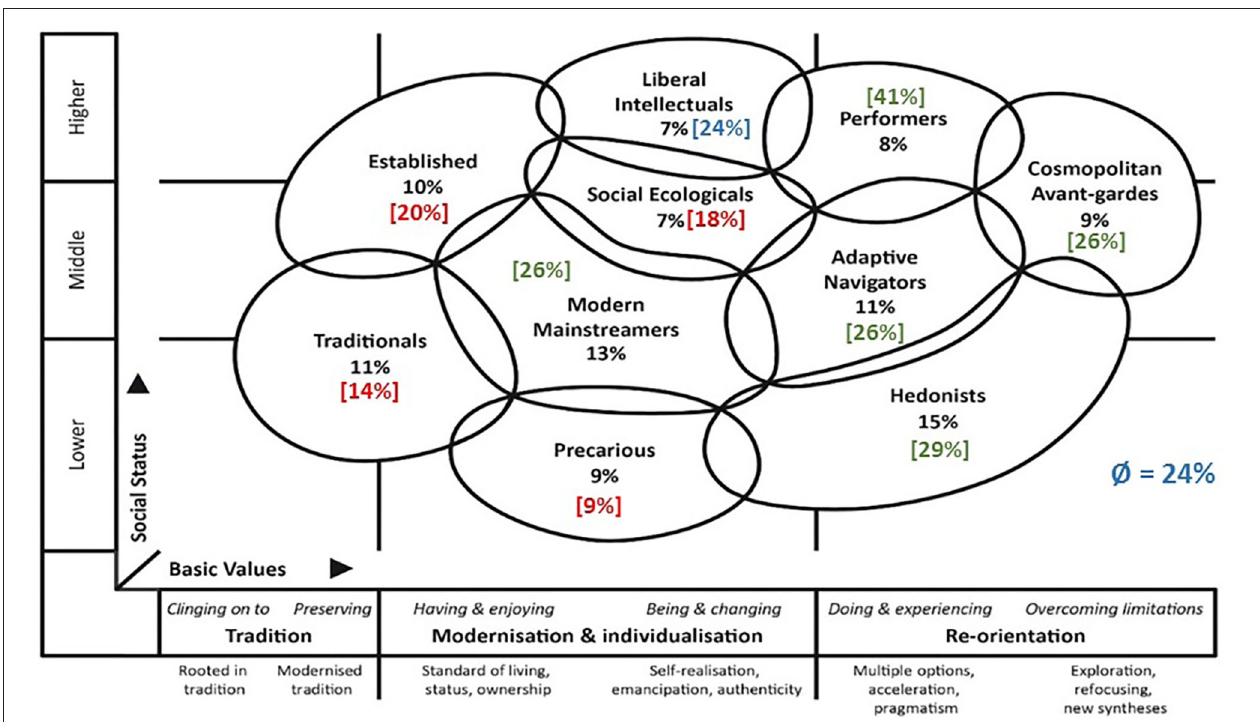
FIGURE 8 | Sinus-Milieus in Germany 2020 and their percentage of the adult population (percentage points in black). In color and in bracket: share of respondents stating that Corona restrictions have improved their environmental awareness; blue: average value, green: above average value, red: below average value. Source: Own Data and BMU/BfN